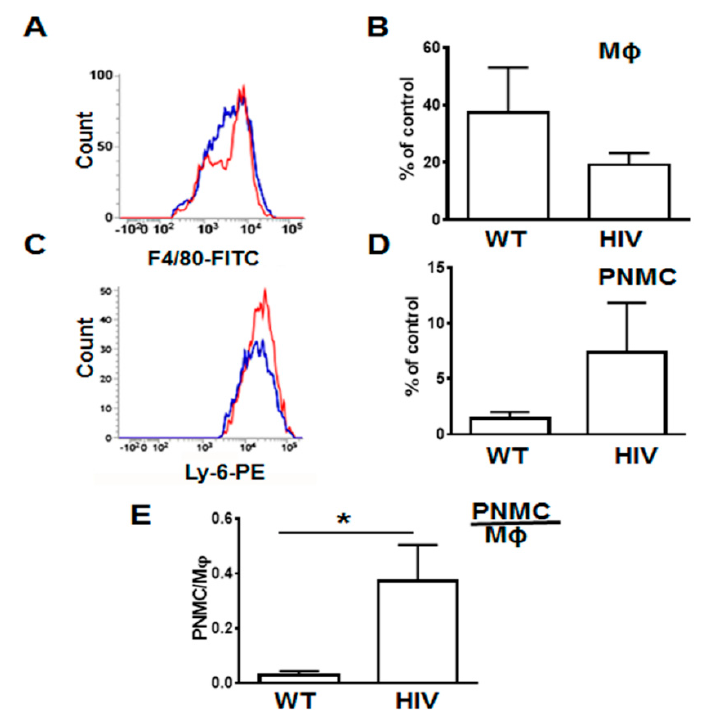
Figure 3. Infiltration of lung neutrophils is increased and lung interstitial macrophages is decreased in HIV-Tg mice at 24 h after LPS injection. ( A , B ) Representative image of flow cytometry for macrophages (A, M φ ) and quantification of flow cytometry data (B). ( C , D ) Representative image of flow cytometry for neutrophils (C, PNMC) and quantification of flow cytometry data (D) in WT (blue color) and HIV-Tg (red color) mice. ( E ) neutrophil / macrophage ratios. Results were obtained from 5 mice were used for quantification. Asterisk indicates * p < 0.05.